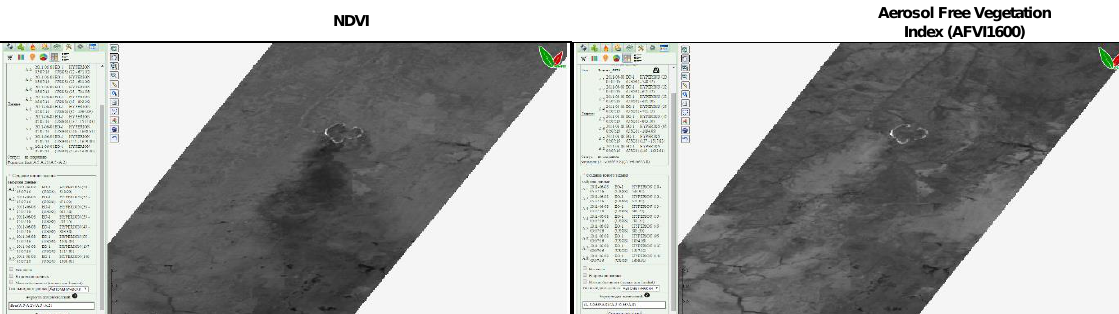
Figure 15. Effectiveness of VEGA system Web interface for forest fire detection based on HSD usage (Hyperion,